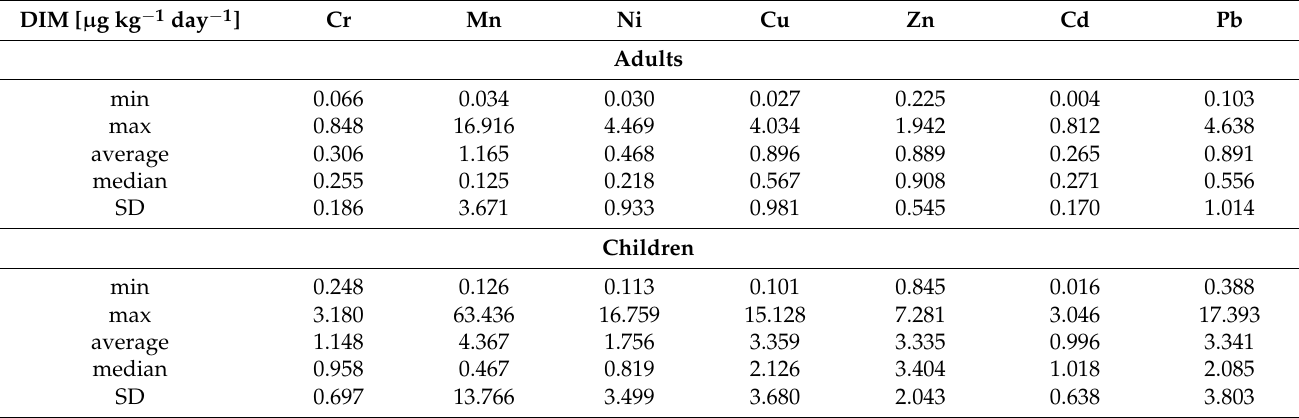
Figure 3. The estimated daily intake represented as box-plots for seven toxic metals in well water. Considering the obtained results for estimated daily intake and the body mass for adults (~70 kg) and children (~14 kg) the values for daily intake metals from drinking waters are presented in Table 8, Figure 4, and Table S1 from Supplementary Material. The maximum values for Cr, Mn, Ni, and Cu were determined in the P2 sample (for adults and children). In both cases, the highest value for Zn was determined in P18 sample, for Cd in P1 sample, respectively in P9 sample for Pb. Table 8. Daily intake metals from well water.